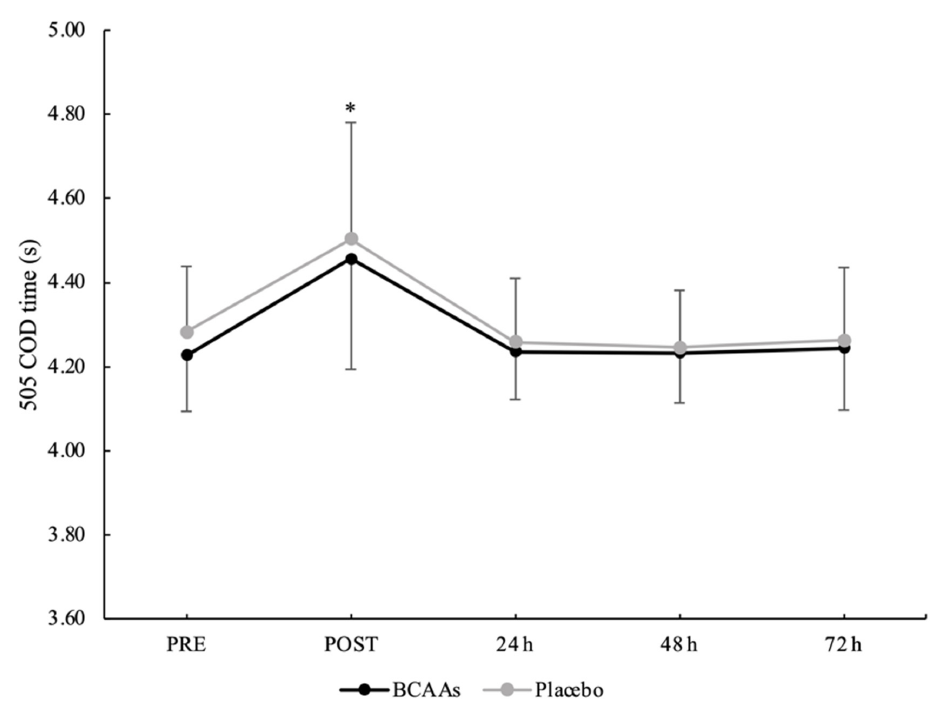
Figure 6. Total time for the 505 COD test during the time course of recovery. (*) Denotes differences ( p < 0.05) from all time-point measurements.